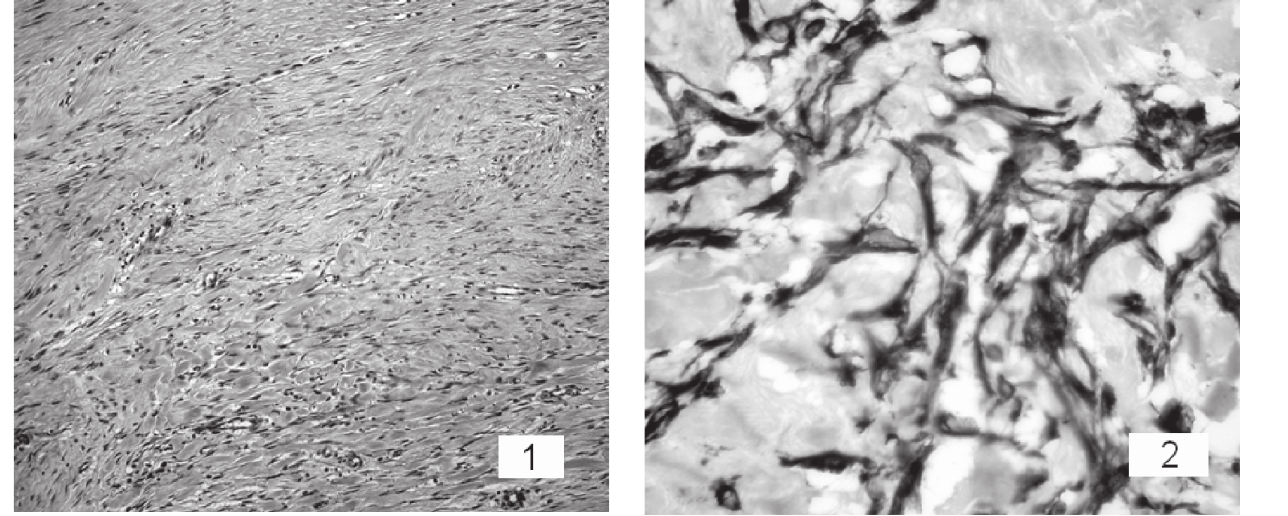
Figure 2 . Immunohistochemical histology of fibromatosis of the male breast showing diffuse positivity for vimentin (dark-stained cytoplasm) (original magnification